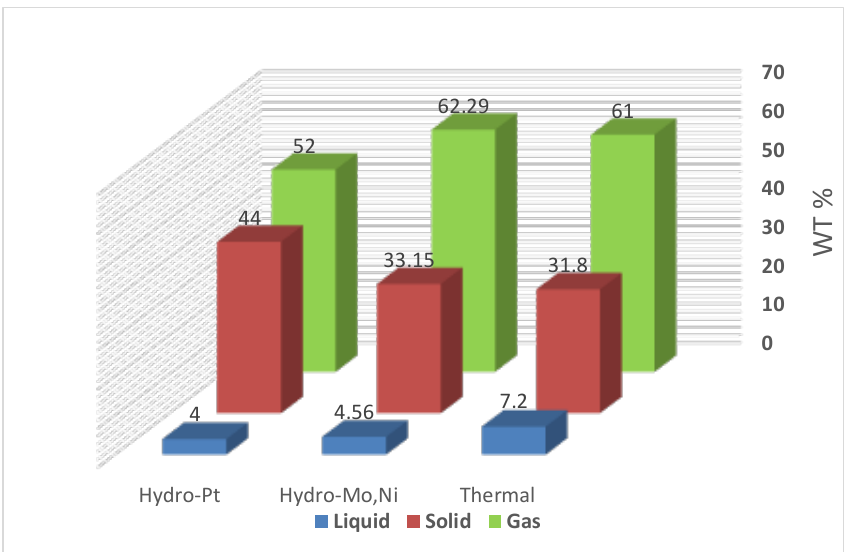
Figure 6: The spectra of products for all types of